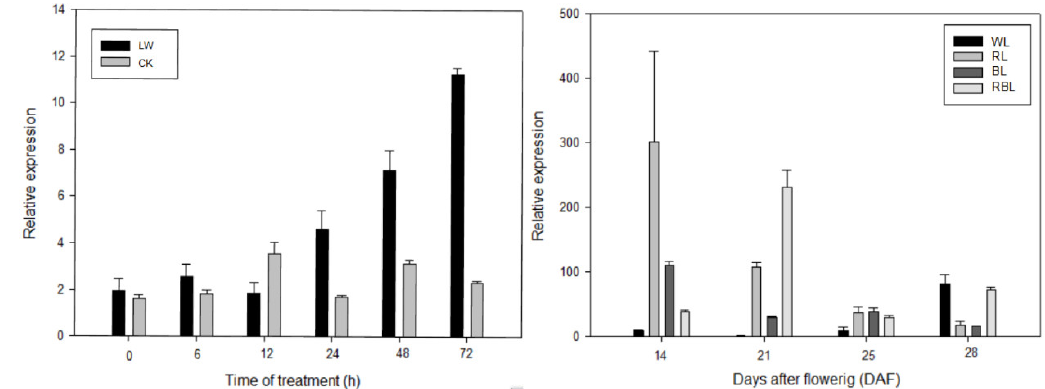
Figure 4. Expression level of FvSnRK1.1 under low temperature and light quality treatment. LW, low temperature; WL, white light; RL, red light; BL, blue light; RBL, mixed light (red: blue = 1:1).